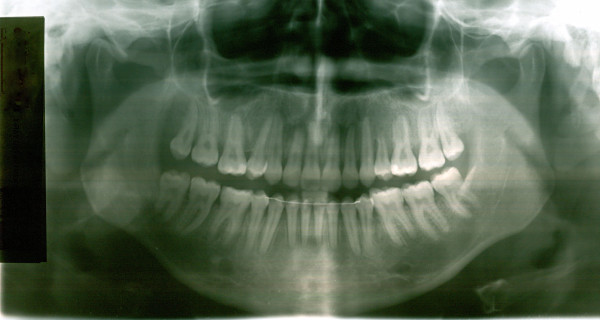
Final OPG of case 2.